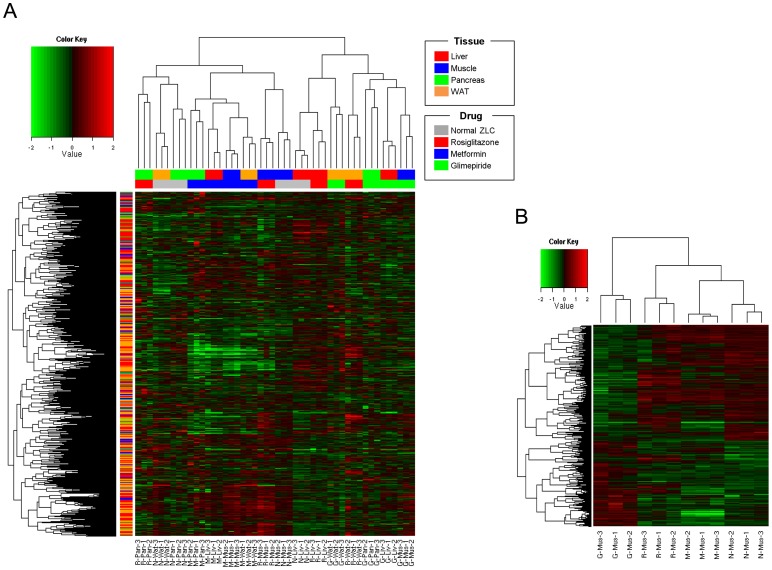
Hierarchical clustering analysis.(A) Expression heat-map with 5,650 differentially expressed genes (DEGs) (excluding the common response DEGs) in all 48 samples. The first row of the color legend under the hierarchical clustering by column indicates sample's tissue type, and the second is the drug type. Another color legend on the side identifies the drug target information. (B) Expression heat-map with 857 genes in 12 muscle samples. (p value <0.05 and remove common DEGs and drug-response DEGs) G, Glimepiride; M, Metformin; R, Rosiglitazone; N, normal ZLC.